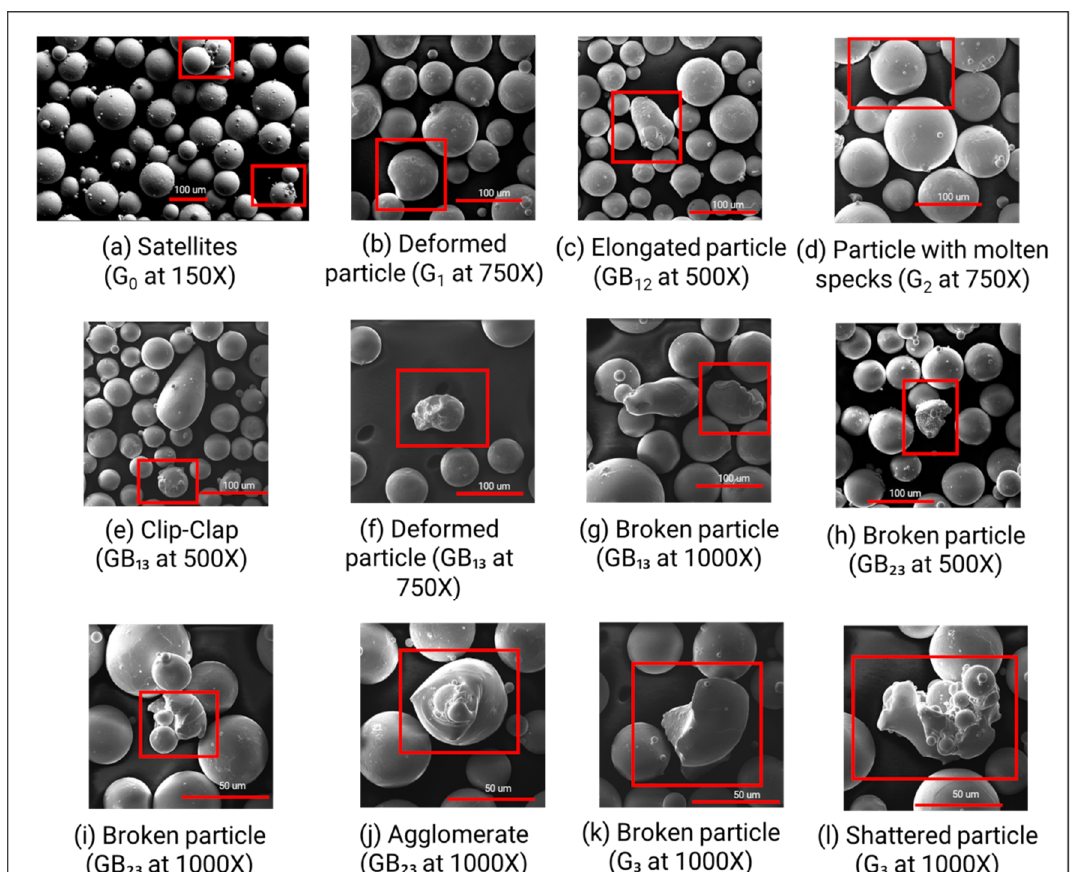
Figure 2. SEM micrographs for all powder types depict ( a ) satellites in G 0 powder; ( b , f ) deformed particle in G 1 and GB 13 powders, respectively; ( c ) elongated particle in GB 12 powder; ( d ) particle with molten specks in G 2 ; ( e ) clip-clap in GB 13 powder; ( g , h , i , k ) broken particles in GB 13 , GB 23 and G 3 powders; ( j ) agglomerate in GB 23 powder and ( l ) shattered particle in G 3 powder. Nomenclature used to describe these micrographs was first defined by Popov et al. [26]. A Zeiss Ultra SEM instrument was used to capture the image shown in ( a ); all other images were captured using the Tescan VEGA3 instru- ment.